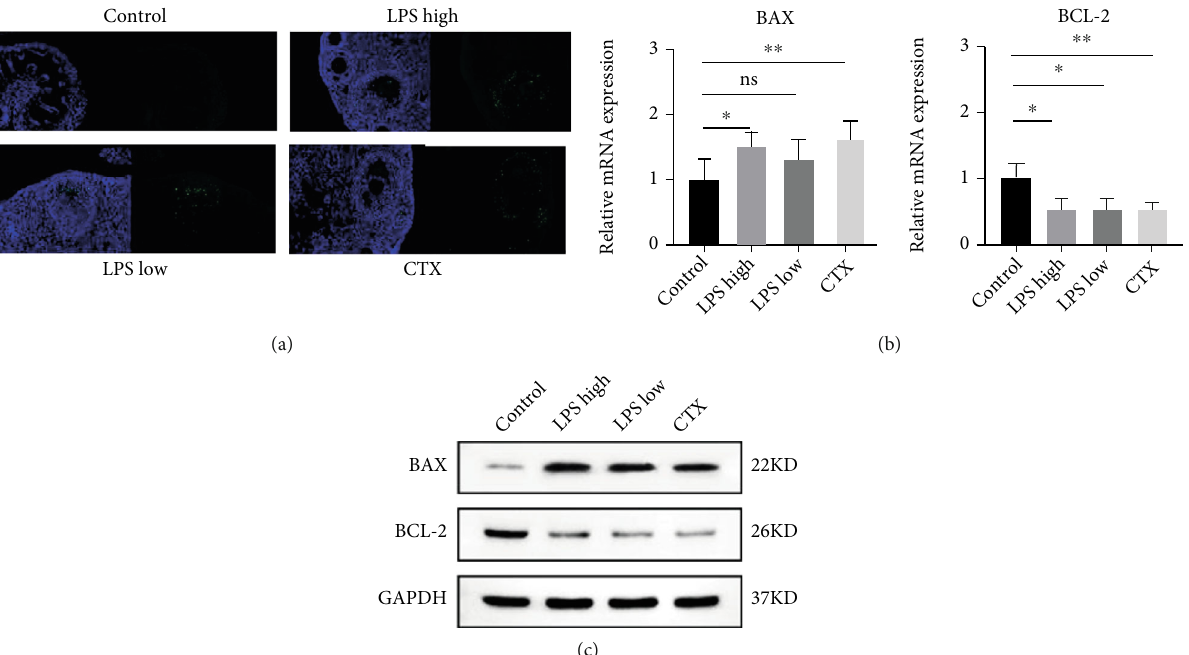
Figure 4: LPS stimulation induced granulosa cell apoptosis in mouse ovaries. (a) TUNEL assay was performed to examine granulosa cell apoptosis in the mouse ovaries. Representative images are shown, blue represents nuclear, and green represents apoptosis granule. Magni fi cation 100x. (b) qRT-PCR and (c) Western blotting were performed to determine mRNA and protein expression of Bax and Bcl- 2 in mouse ovaries. Data are expressed as the mean ± SEM . ∗ P < 0 : 05 and ∗∗ P < 0 : 01 ; ns: nonsigni fi cant, n = 10 .